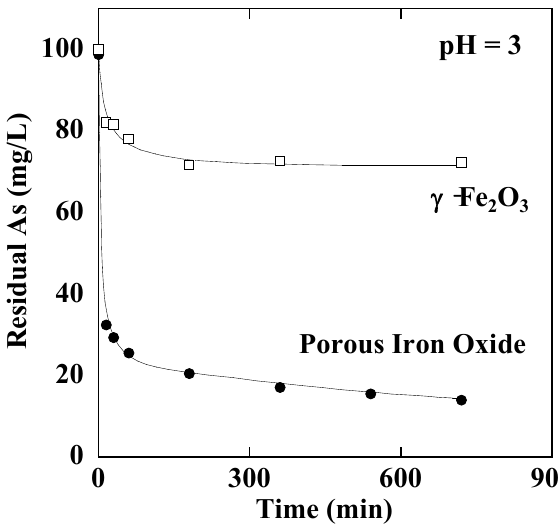
Figure 7. The As concentration in an aqueous solution of pH 3 versus time after immersion of porous iron oxide particles or (cid:2) -Fe 2 O 3 particles in the solution. The As con- centration decreases as a result of As adsorption onto the